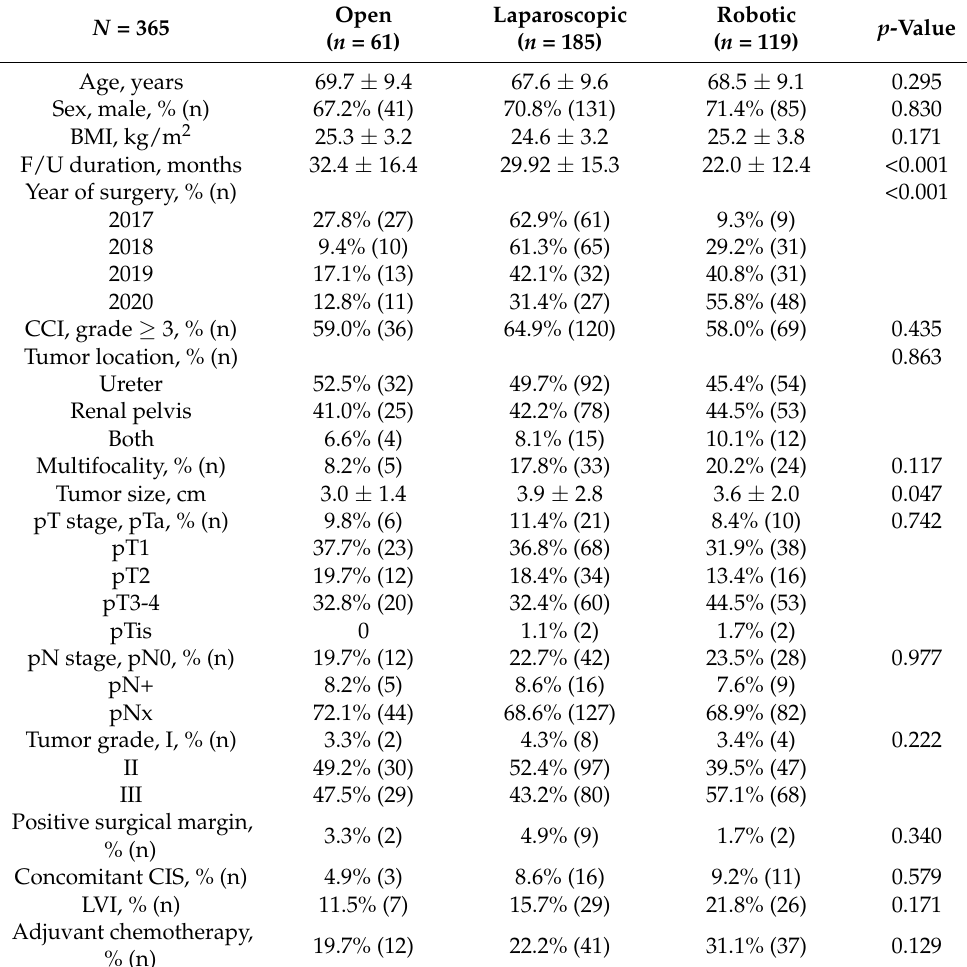
Table 1. Baseline characteristics.